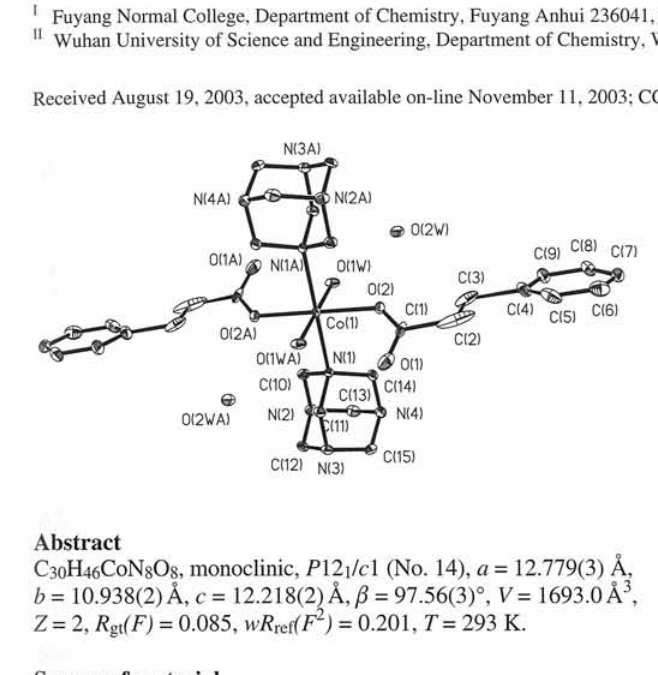
Table 1. Data collection and handling.